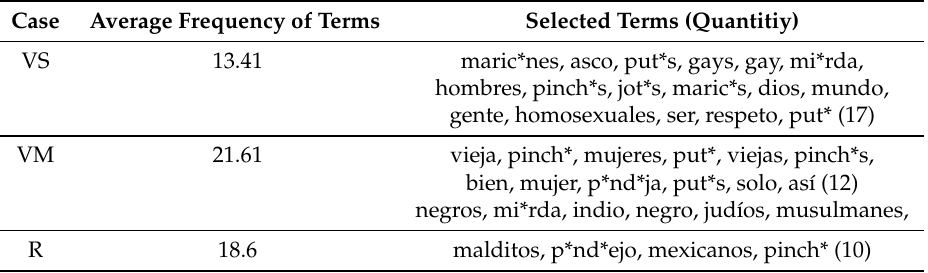
Table 5. Selected terms by their average frequency for each type of